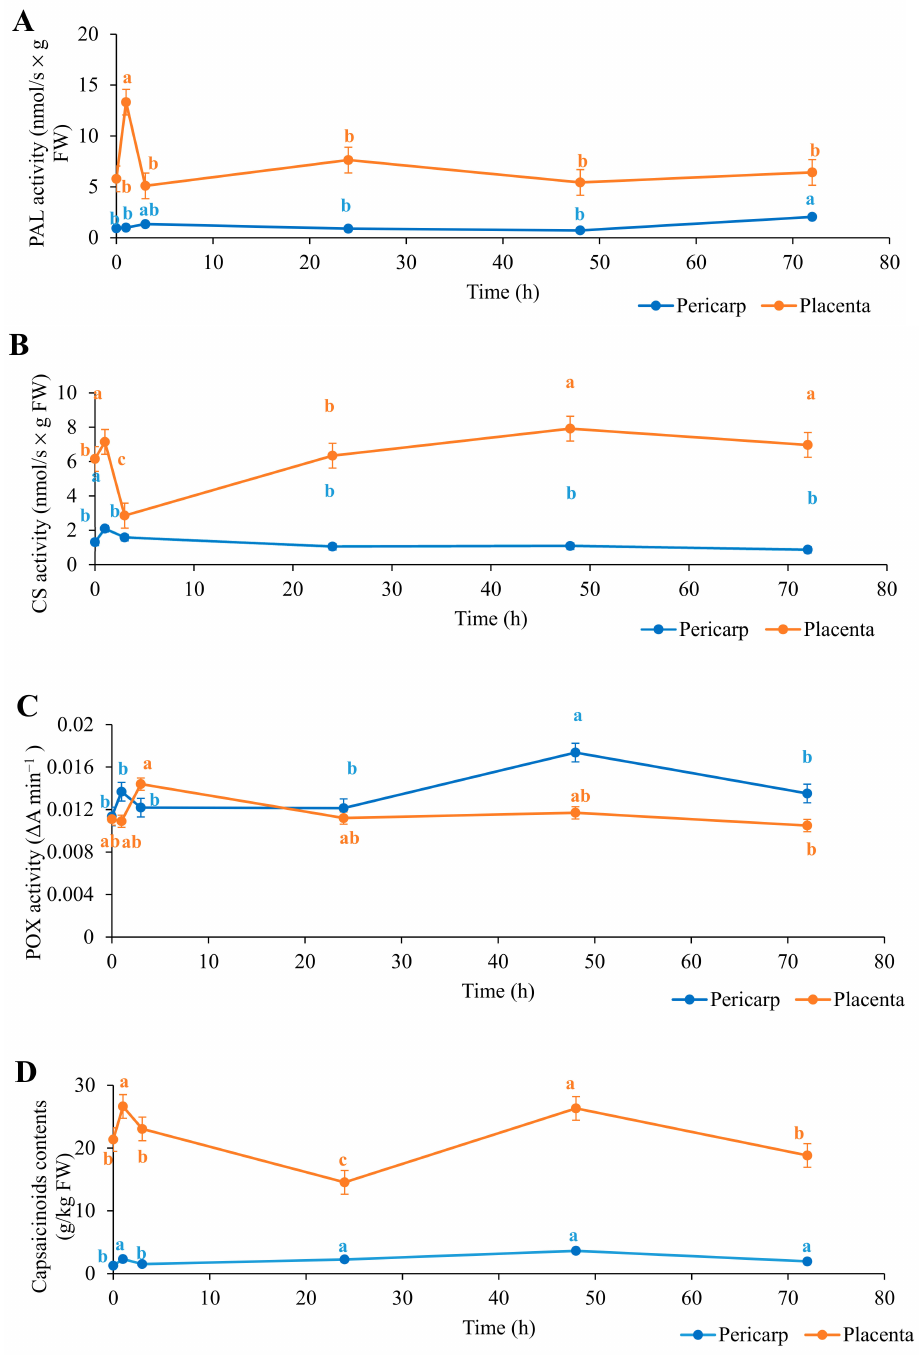
Figure 1. Time courses following biostimulant application for the absolute enzyme activities for phenylalanine ammonia lyase (PAL; ( A )), capsaicin synthase (CS; ( B )), and peroxidase (POX; ( C )) and for the total capsaicinoid content ( D ) in pericarp and placenta of the chili fruit. Data are means ± standard error (n = 5). Data with different lowercase letters are significantly different (ANOVA; Tukey’s